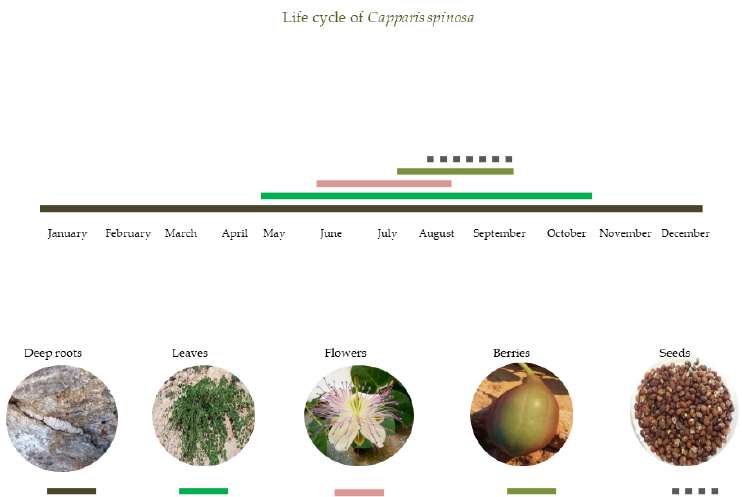
Figure 2. Schematic presentation of the life cycle and phenological stages (indicated using colorful horizontal lines and a dotted line) of C. spinosa : leaf initiation and longevity (green line) from May to October, flowering (pinkish line) from June to mid-August, fruiting (olive-green line) from late July to mid-September, seed maturation (dark dotted line) from late August to September, and roots existing throughout the year.